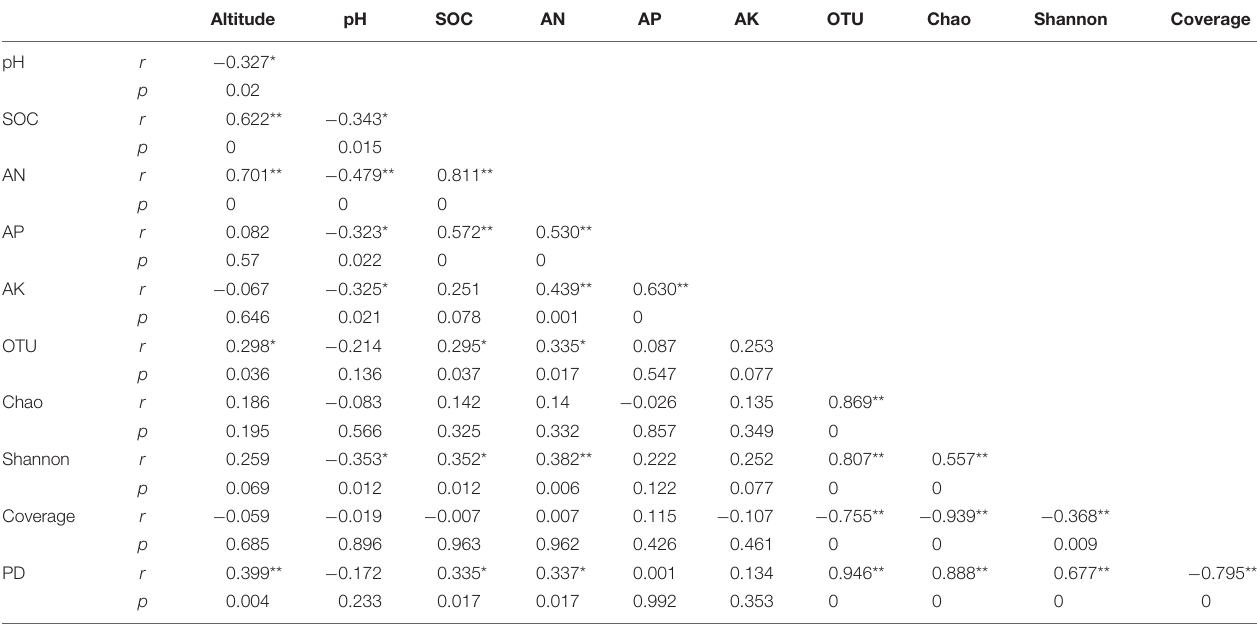
TABLE 3 | The Spearman correlation matrix between soil/site properties and diversity indexes. Altitude pH SOC AN AP AK OTU Chao Shannon Coverage